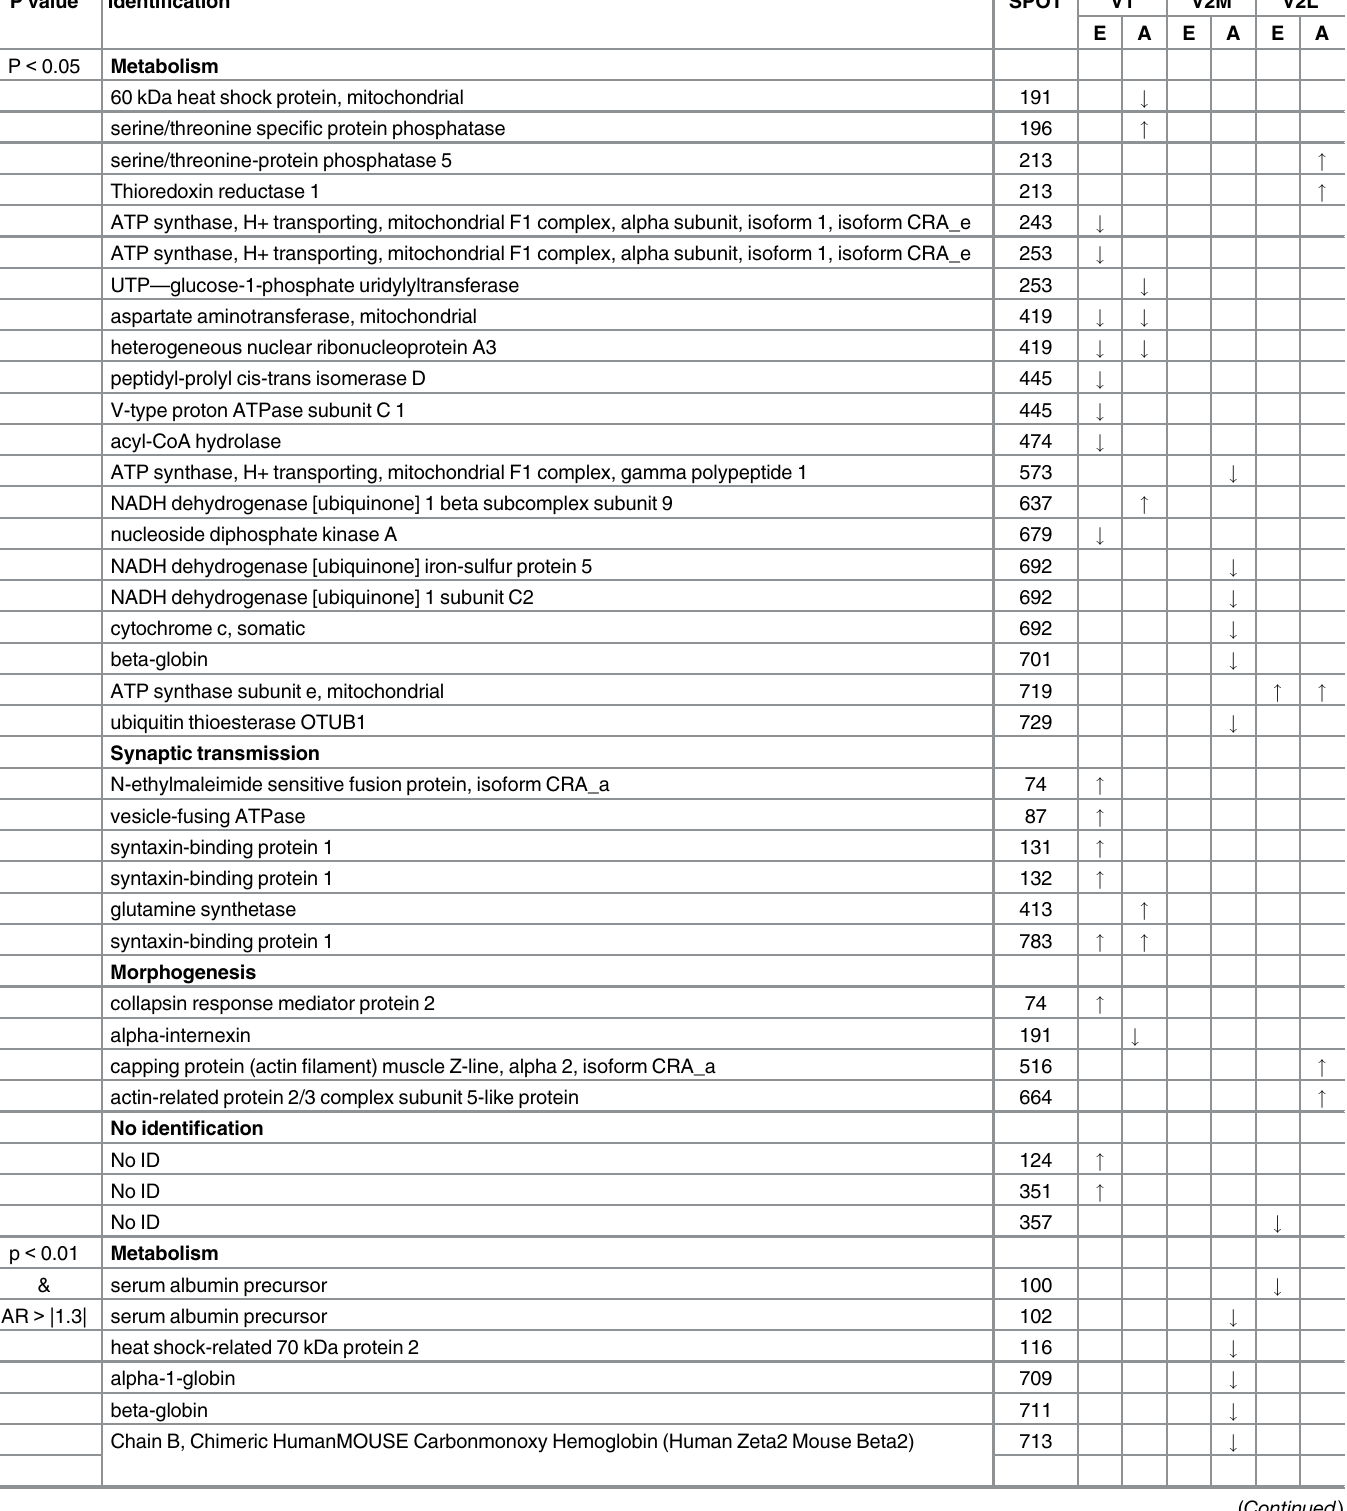
Table 3. Variation in expression levels in enucleated (E) and anophthalmic (A) mice. P value P < 0.05